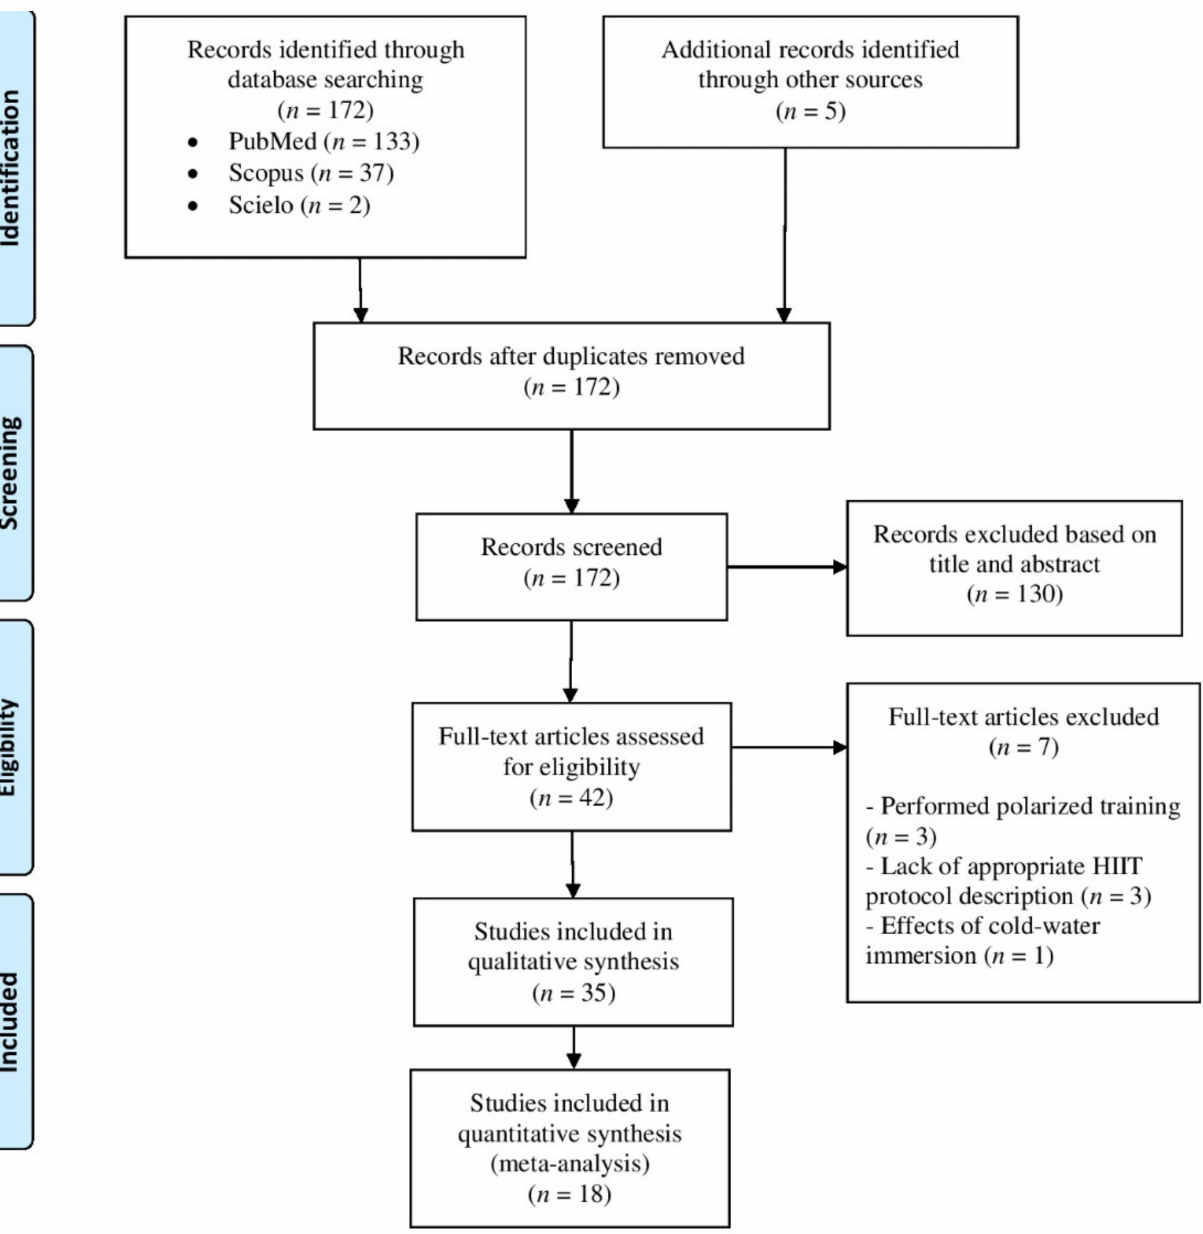
Figure 1. Flowchart of study